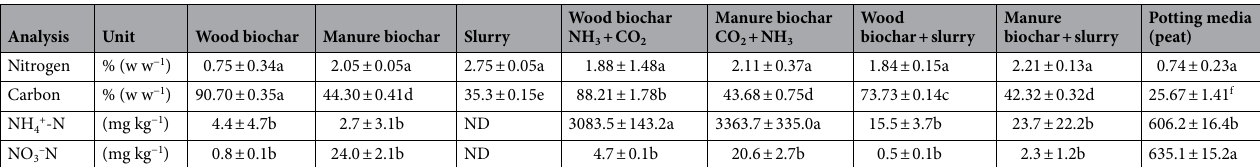
Table 1. Total carbon and nitrogen and KCl-extractable ammonium (NH 4+ -N) and nitrate (NO 3– N) in amendments used for the greenhouse trial ± the standard deviation. ND not determined, as KCl extraction of slurry is not an appropriate measure plant-available N. Letters indicate significant differences between amendments using a one-way anova (p < 0.05; n =